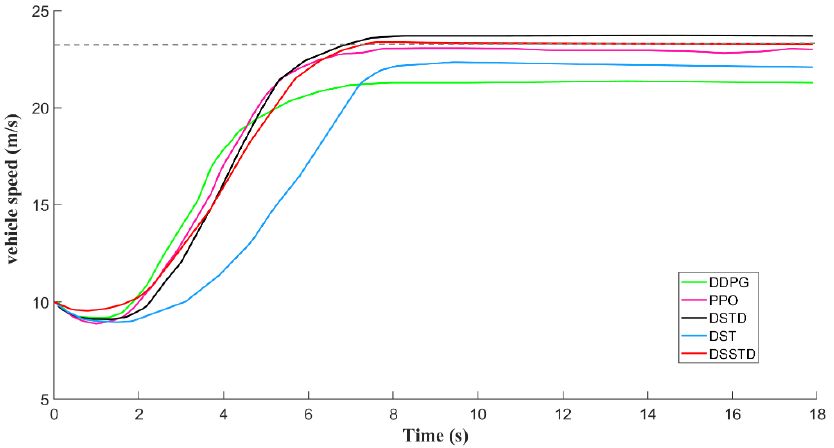
Figure 13. The speed curve of the AV in the test round.